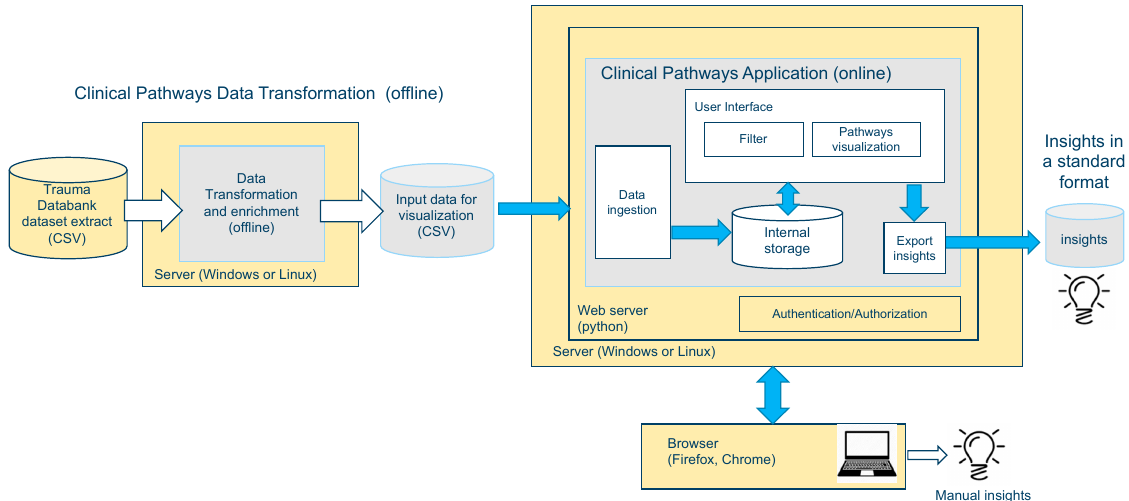
Figure 1. The digital architecture of the Sankey visual analytics tool modified for use in polytraumatized patients. Table 2. General characteristics of the validation group and the development group.